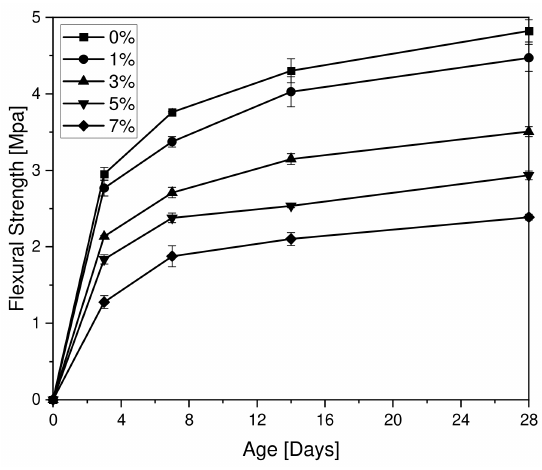
Figure 12. Flexural strength of alkali-treated